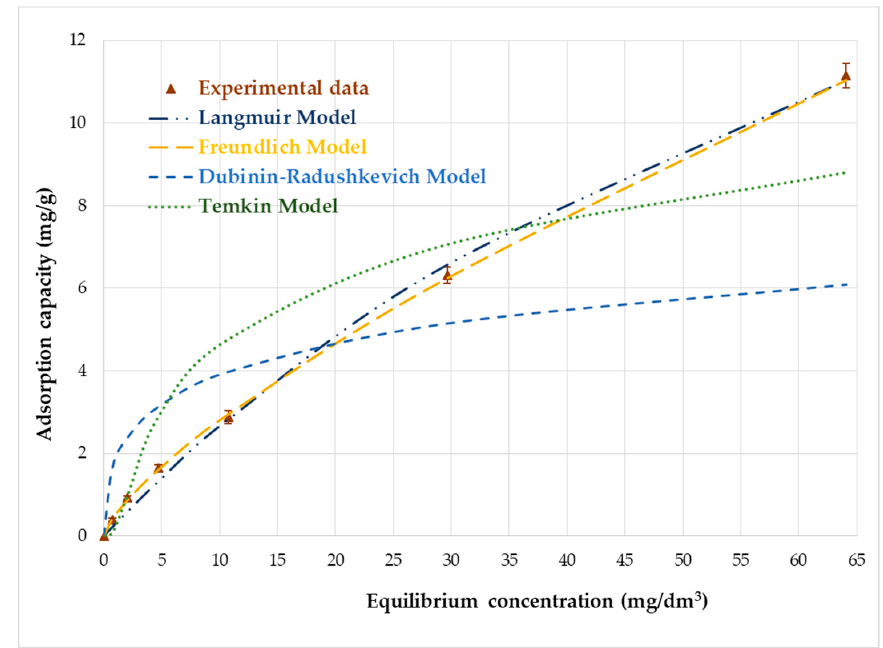
Figure 9. Boron adsorption isotherms on La-CTS hydrogel beads: experimental curve and Langmuir, Freundlich, Dubinin–Radushkevich, and Temkin models at 20 ± 1 °C and time of 24 h.